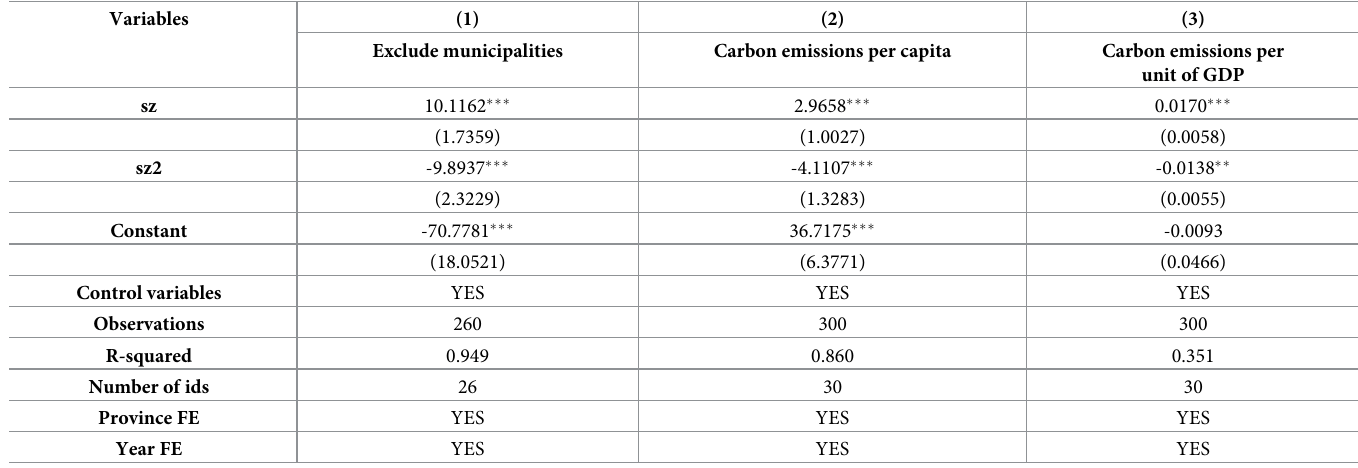
Table 8. Robustness